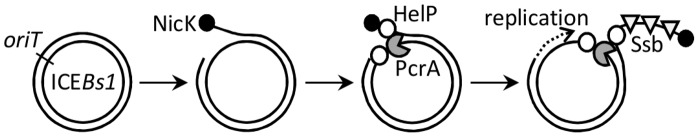
Model for association of the relaxase, helicase, HelP, and Ssb with ICEBs1 DNA.Following excision from the chromosome (not shown), the double-stranded circular ICEBs1 DNA is nicked at oriT by the relaxase NicK (filled circle). By analogy to related relaxases, NicK likely becomes covalently attached to the 5′ end of the nicked DNA on the strand that is transferred during conjugation. HelP (open circles) and the host-encoded helicase PcrA (gray packman) associate with the nicked ICEBs1 at oriT. HelP facilitates processive unwinding of ICEBs1 by PcrA and subsequent association of the host-encoded Ssb (open triangles). Unwinding of ICEBs1 by PcrA and HelP is required for replication and conjugation of ICEBs1. HelP is depicted as binding to both single strands of ICEBs1 DNA adjacent to PcrA, although it is possible that HelP associates only with one of the two single strands.